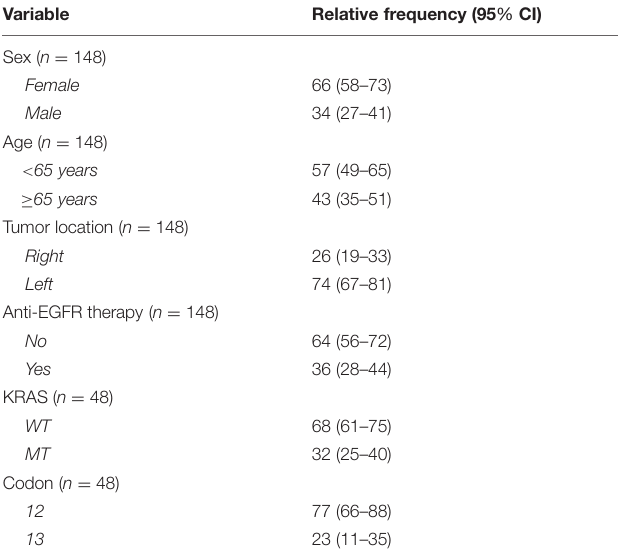
TABLE 1 | Patient characteristics.